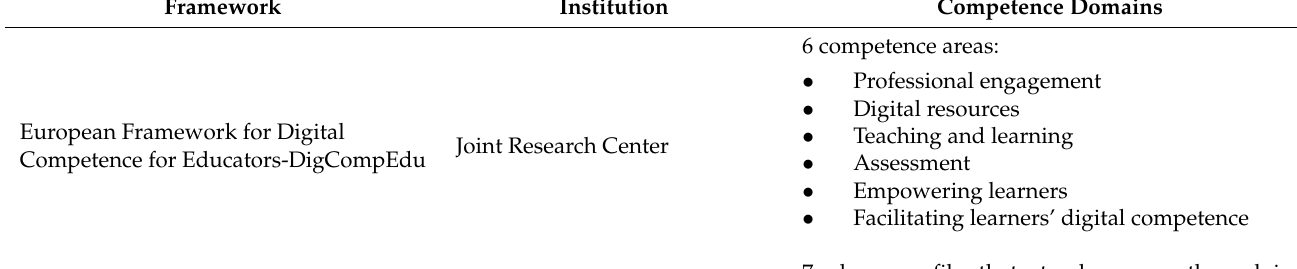
Table 1. More consolidated and significant competence